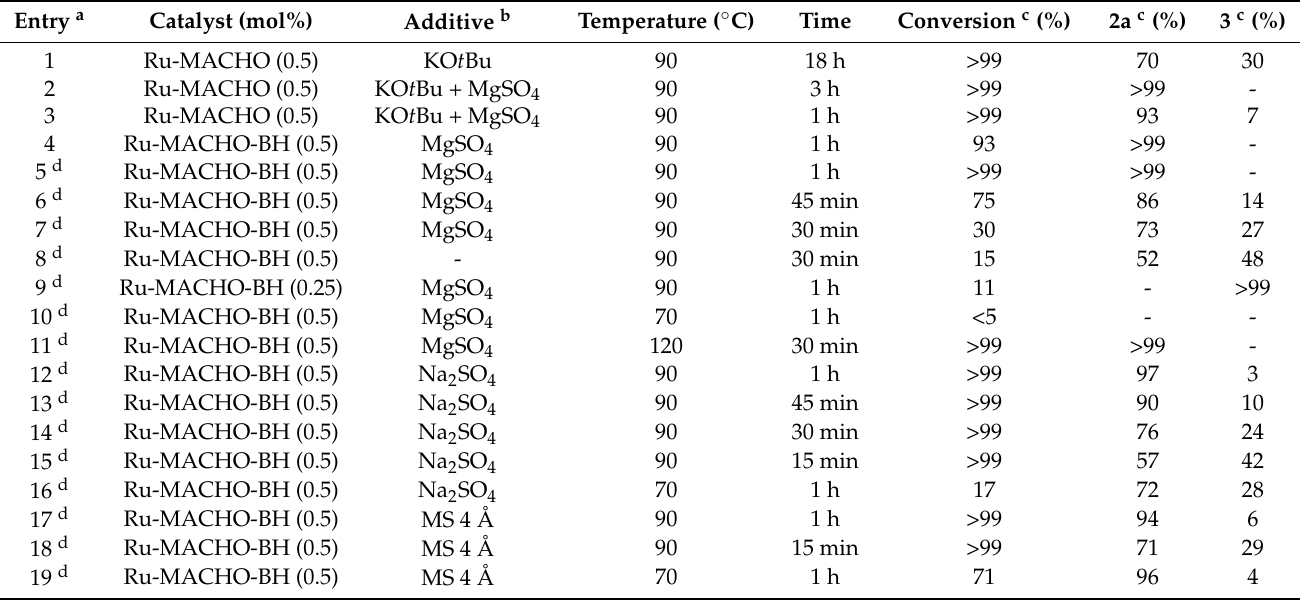
Table 2. One-pot synthesis of furfurylamines: Optimization.